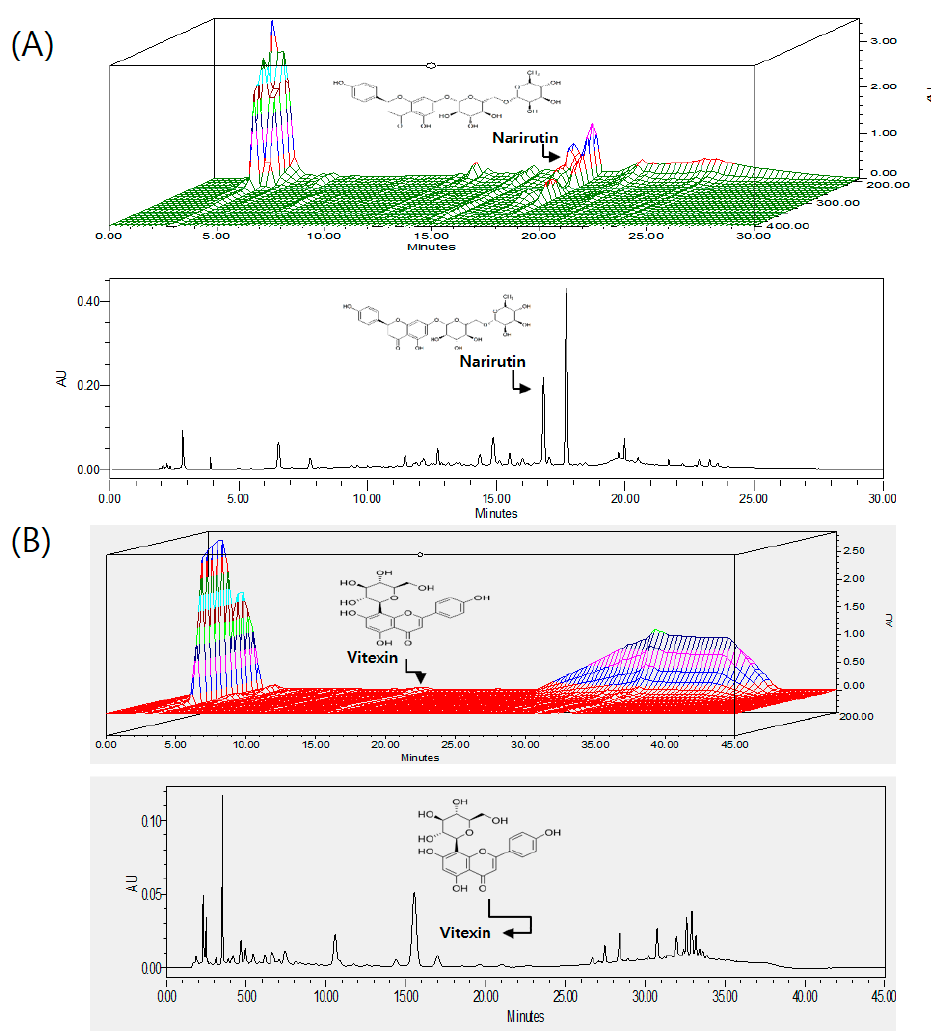
Figure 5. 3-D HPLC chromatogram of HT048, a blend of two herbal extracts ( A ) C. unshiu peel of narirutin; ( B ) C. pinnatifida leaves of vitexin.